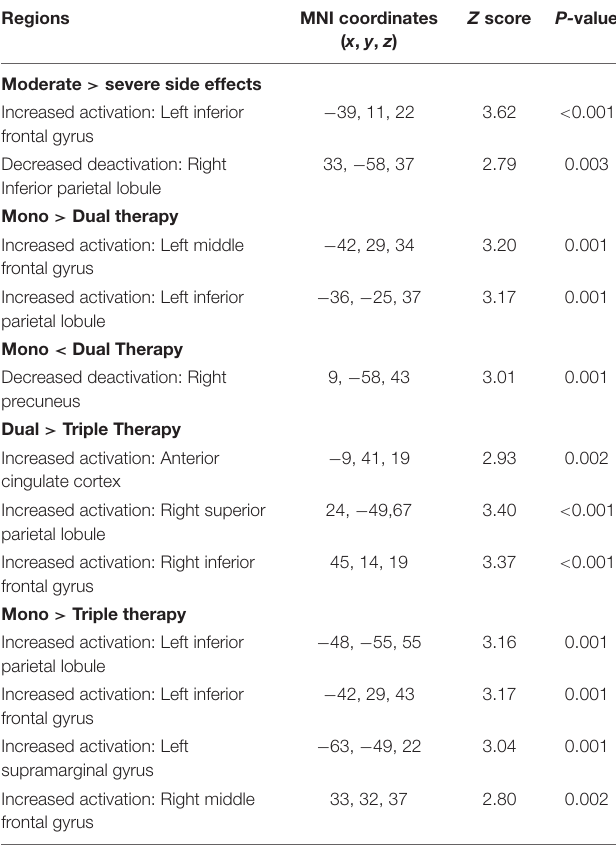
TABLE 4 | Anatomic description and peak activations of resultant areas from group comparisons. Regions MNI coordinates